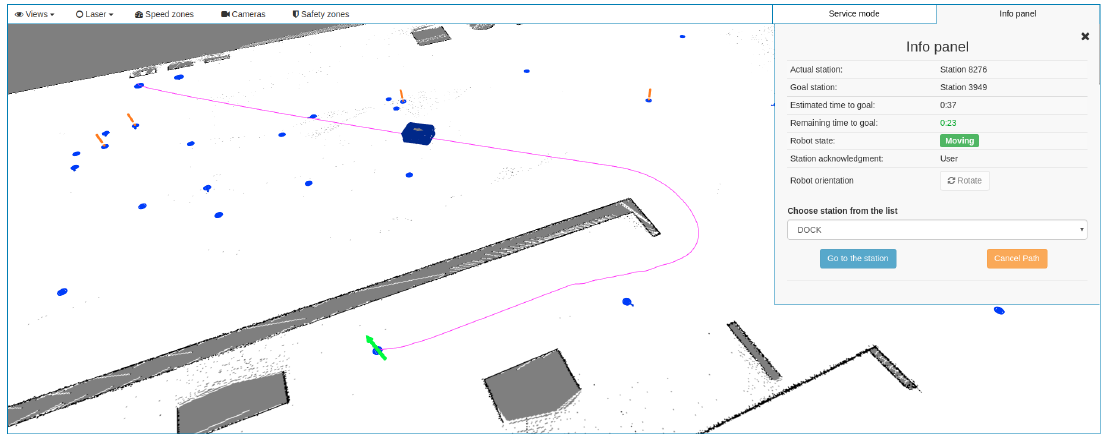
Figure 10. An example of a dynamic trajectory